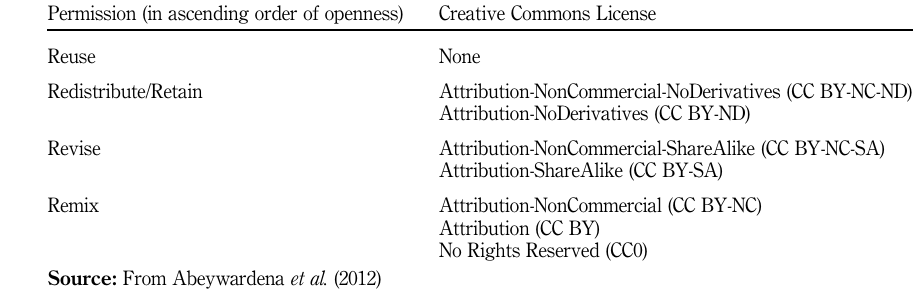
Table II. Mapping of the creative commons licenses to the five ‘ R ’